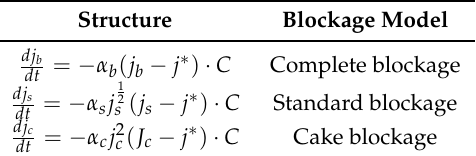
Table 6. Kilduff fouling models